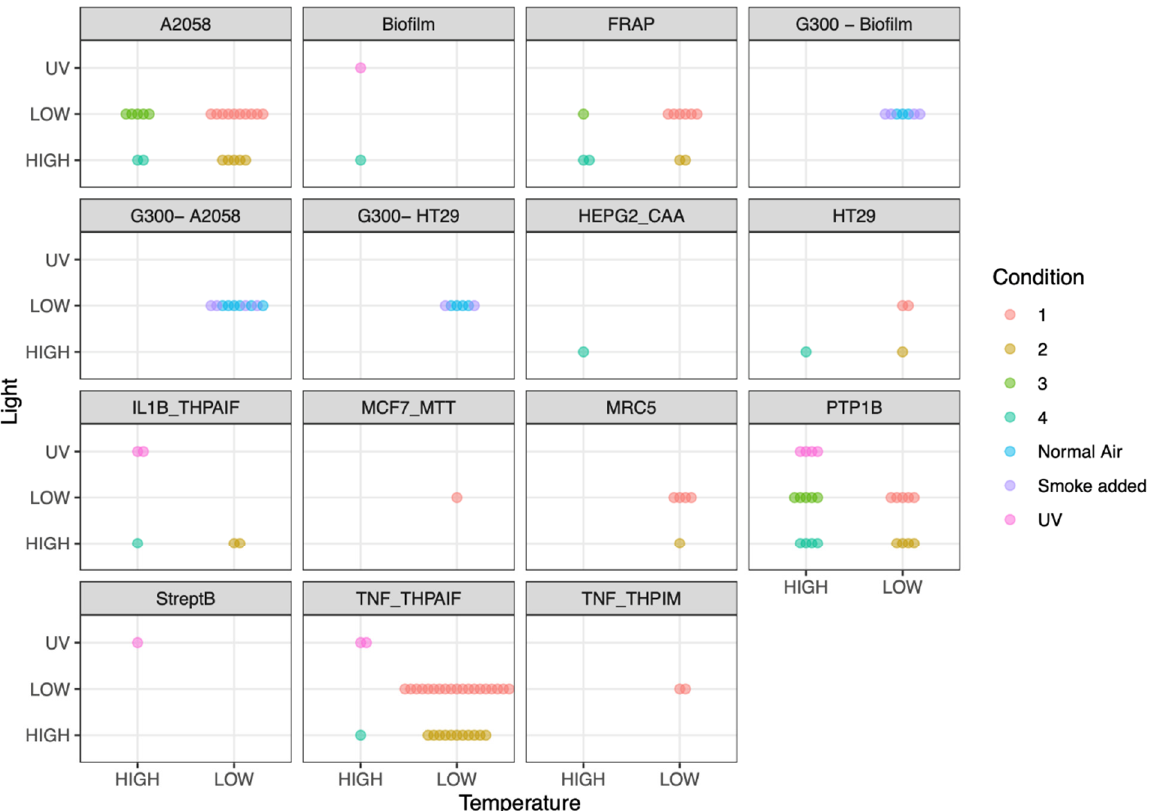
Figure 16. Overview of positive results (hits) from bioactivity testing of diatom extracts. Testing was performed in two rounds using two different strains of the diatom species, as reported in Osvik et al. [104] and Ingebrigtsen et al. [107]. Each dot in the facets represents a positive hit in the respective assay. The color coding and x and y -axes are cultivation conditions; please note that “smoke or no- smoke” condition is only tested in the G300 photobioreactor. Results from assays G300–A2058, G300-Biofilm and G300–HT29 were reported in Osvik et al. [104], and HPLC fractioned extracts tested in A2058, FRAP, PTP1B and TNF_THPAIF/IM were reported in Ingebrigtsen et al. [107], see Figure 17. Color coding for conditions 1–4 was added for readability. The figure was made using RStudio Version 1.4.1106.